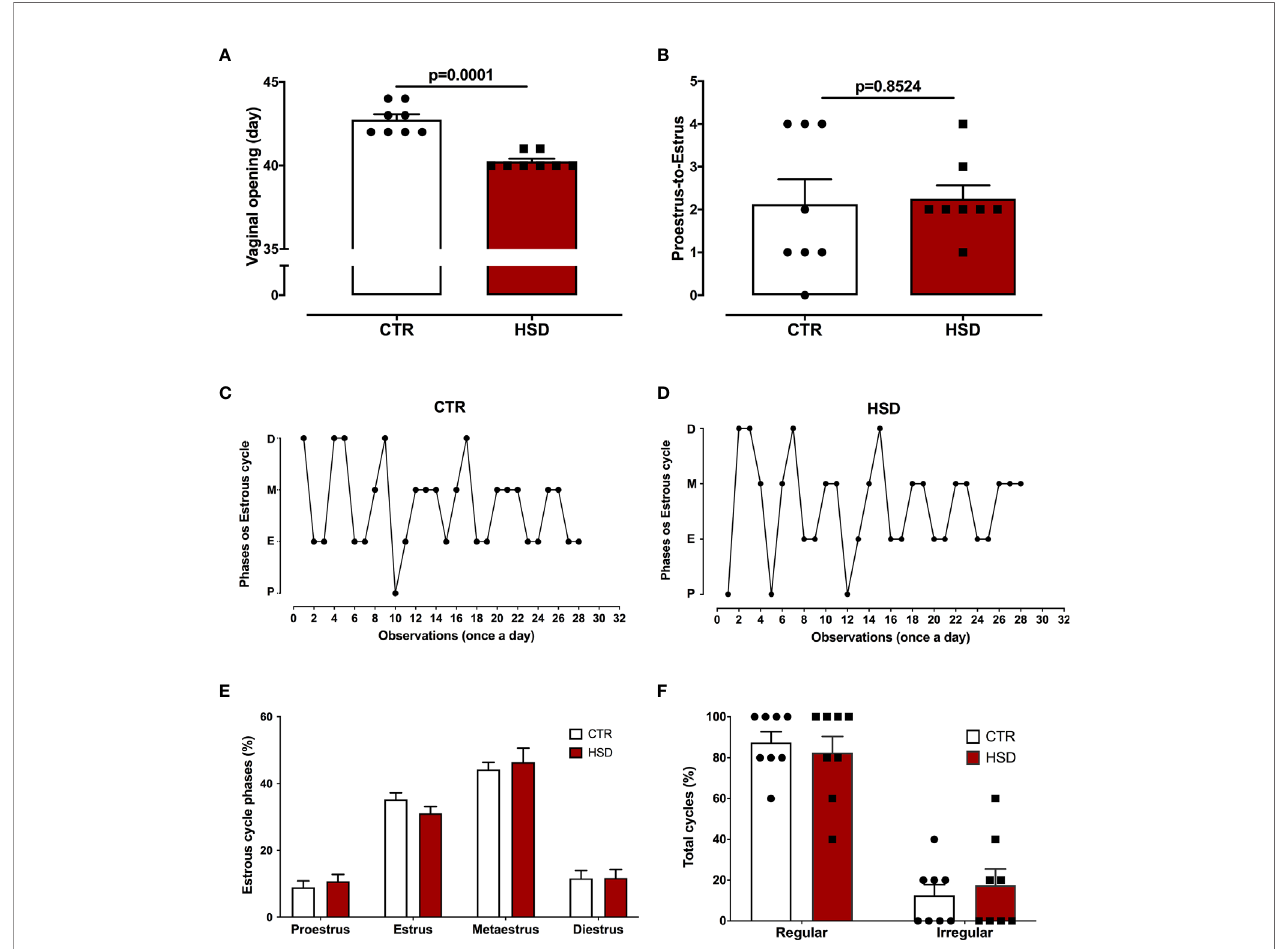
FIGURE 3 | High-sucrose diet (HSD) exposure anticipates puberty. (A) Vaginal opening assessed daily, beginning at pnd 21. (B) Proestrus-to-estrus change as a surrogate for ovulation. (C) Oestrous cycles from a representative CTR rat, where proestrus (P), oestrus (E) , metestrus (M) and diestrus (D) . (D) Oestrous cycle from a representative HSD rat. (E) Percentage of each oestrous phase. (F) Percentage of regular or irregular cycles, as de fi ned in Materials and Methods. n=8 animals in each group. Graphs express mean ± SEM and bar graphs show individual values. P-values are shown in bar graphs when signi fi cant (p < 0.05) and were calculated using unpaired Student t-test in (A) and two-way ANOVA in (D, E)